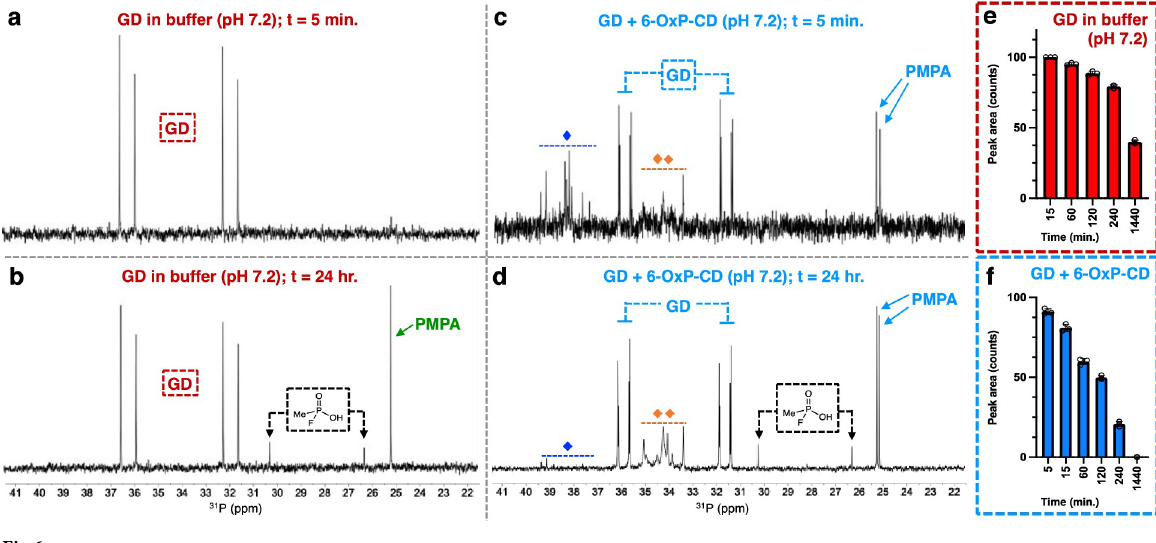
Fig 6. https://doi.org/10.1371/journal.pone.0283181.g006 Incubation of the nerve agents GD and VX with β -CD and 3-PA showed similar degrada- tion profiles during the 31 P-NMR experiments. Thus, incubation of GD in the presence of β - CD results in the slow degradation of the agent with a similar profile to that of its degradation in buffer only after 24 hours (Fig 8A). As observed with GF, β -CD forms an inclusion complex with GD. Thus, it can be anticipated that this binding event by β -CD effectively neutralizes the nerve agent from interacting with AChE in similar fashion to the GF case. The same degrada- tion results are obtained when GD is incubated with 3-PA, with ~60% of the original agent degraded after a 24-hour period of time (Fig 8B). Similarly, incubation of β -CD with VX results in the slow degradation of the nerve agent and curiously at a much slower rate than plain buffer (Fig 8C). At the end of the 24-hour period of time ~80% of the VX agent still